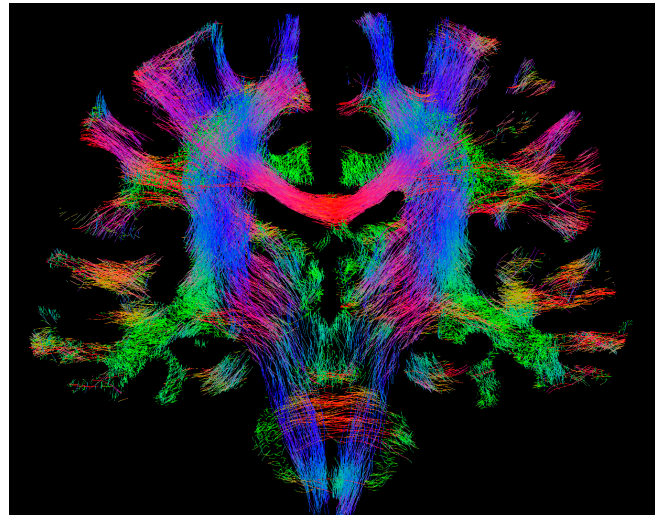
Figure 1. Example whole-brain fibre-tracking results (also referred to as ‘tractogram’) from human healthy subject scanned at 3T. The results shown correspond to 100,000 streamlines from probabilistic tracking, displayed as a 4-mm coronal section. The colour-coding corresponds to the fibre orientation (red: left–right, green: dorsal–ventral, blue: cranial–caudal). Figure previously published in [14], with permission of Springer, 2017.